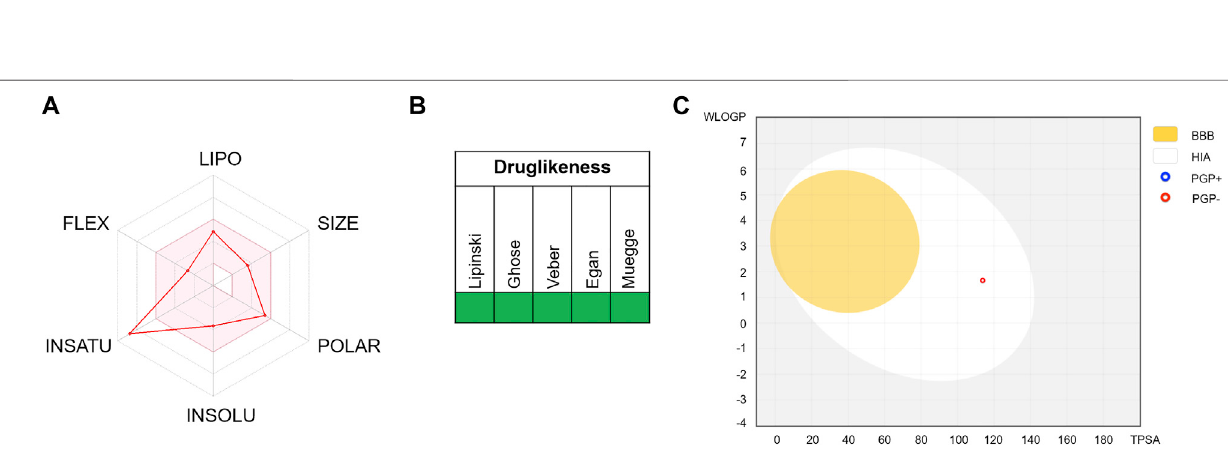
Frontiers in Molecular Biosciences |